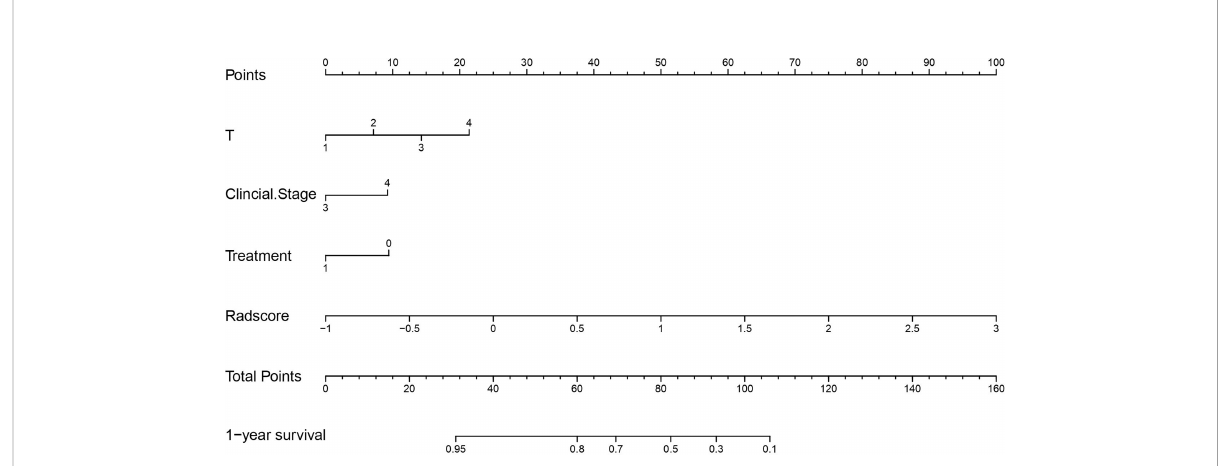
FIGURE 4 Radiomics nomogram for the prediction of progression-free survival in patients with advanced NPC. The radiomics nomogram was developed including the. Radscore ktrans +Ve T stage, clinical stage, and treatment with NTZ incorporated. For each patient, the value of each variable is represented as points by projecting them onto the top line (point scale). Adding the points of all variables and projecting the total points value downward onto the bottom line can be used to calibrate the probability of 1-year progression-free survival. NPC, nasopharyngeal